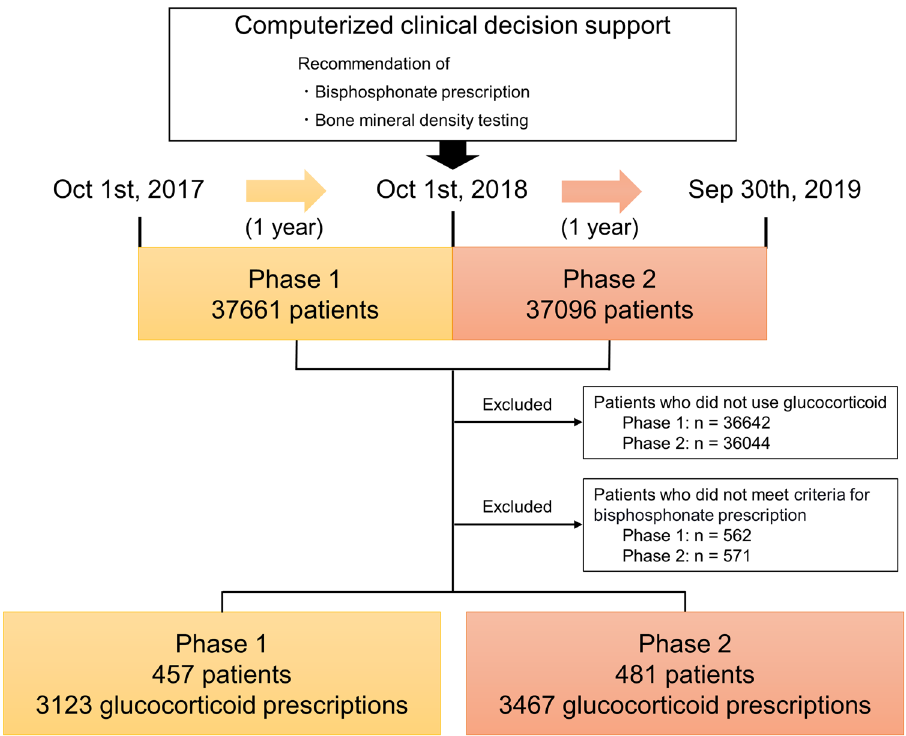
Figure 1. Flowchart of study design and enrolled